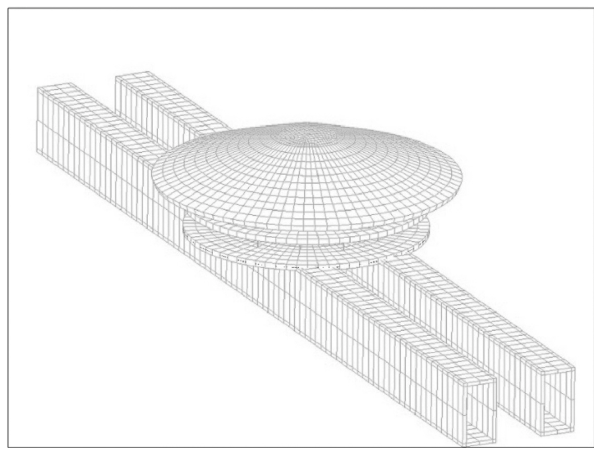
Figure 5: Finite element model of the buffering